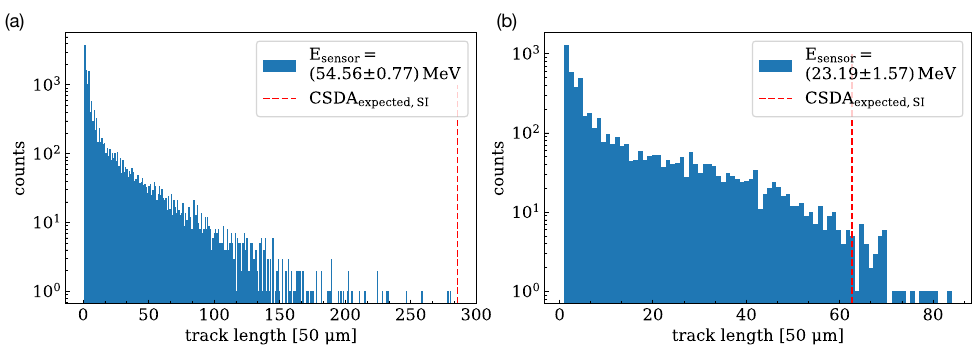
Figure 10. Track length distributions along the beam axis for all tracks measured for two different energies: ( a ) E sensor = ( 54.56 ± 0.77 ) MeV and for ( b ) E sensor = ( 23.19 ± 1.57 ) MeV. The dotted red line indicates the expected CSDA range of the protons in the silicon sensor.